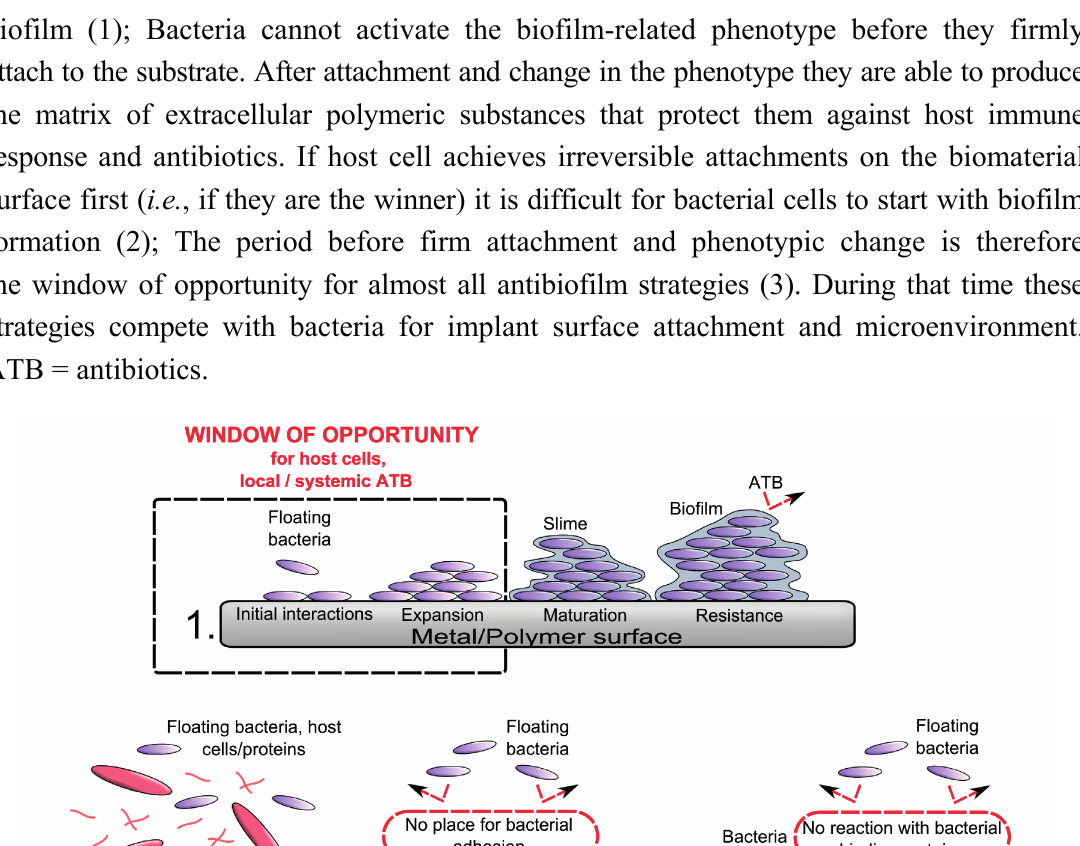
Figure 1. Schematic illustration of the process of biomaterial colonization starting from individual bacteria adhesion across micro-colonies towards formation and maturation